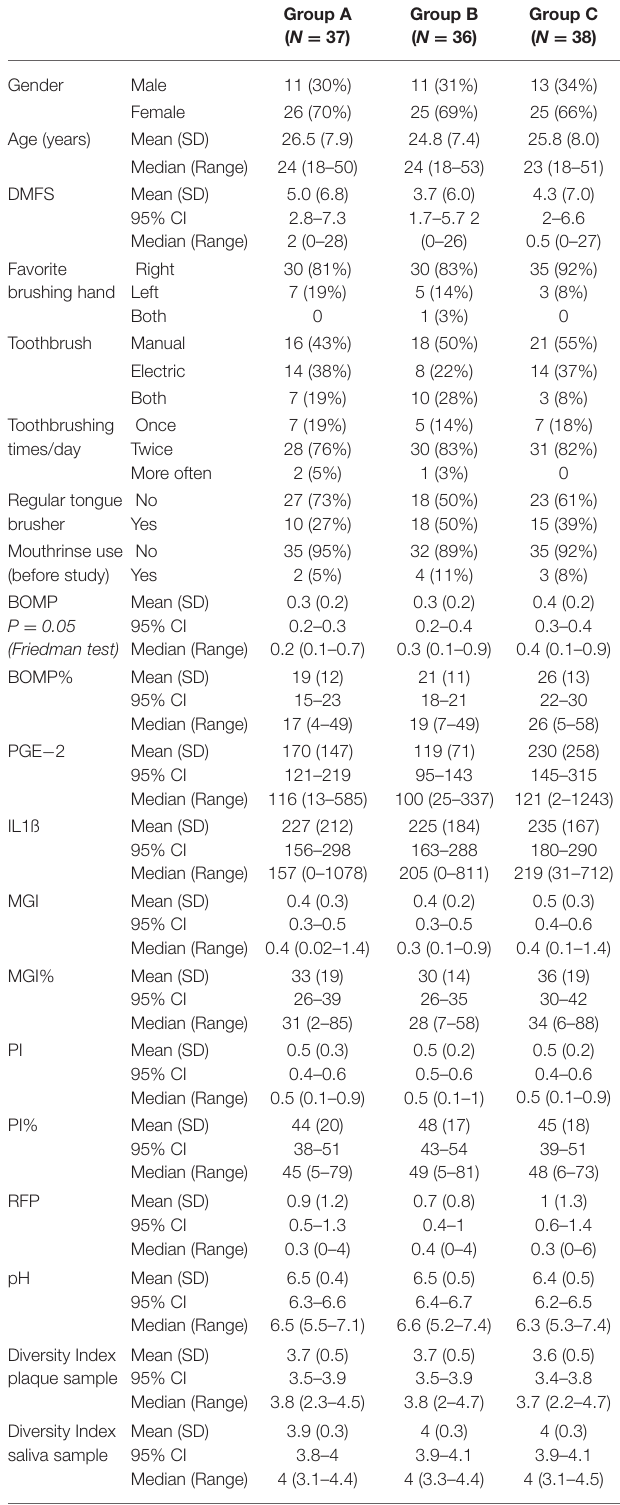
TABLE 1 | Baseline characteristics of the study subjects [safety analysis (SA)/ intention to treat (ITT)